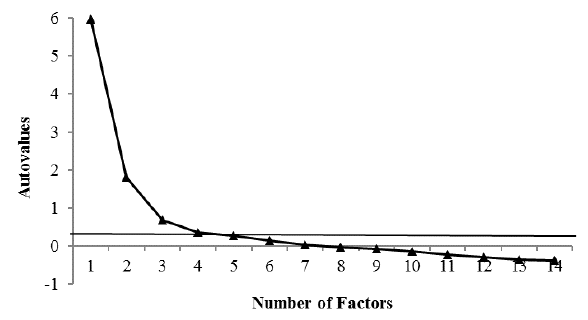
Figure 1. Relationship between number of factors and their respective autovalues from the Scree